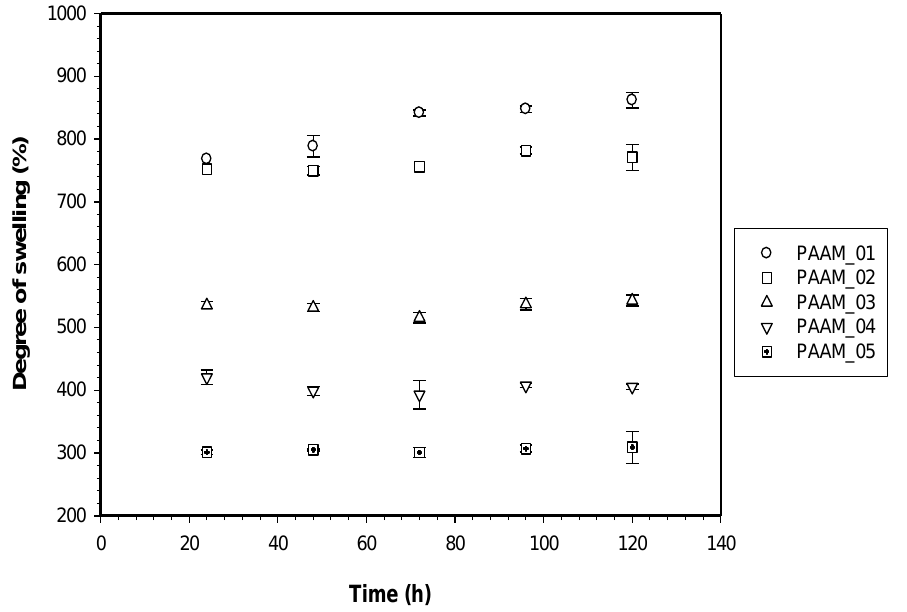
Figure 3. Degree of swelling of polyacrylamide